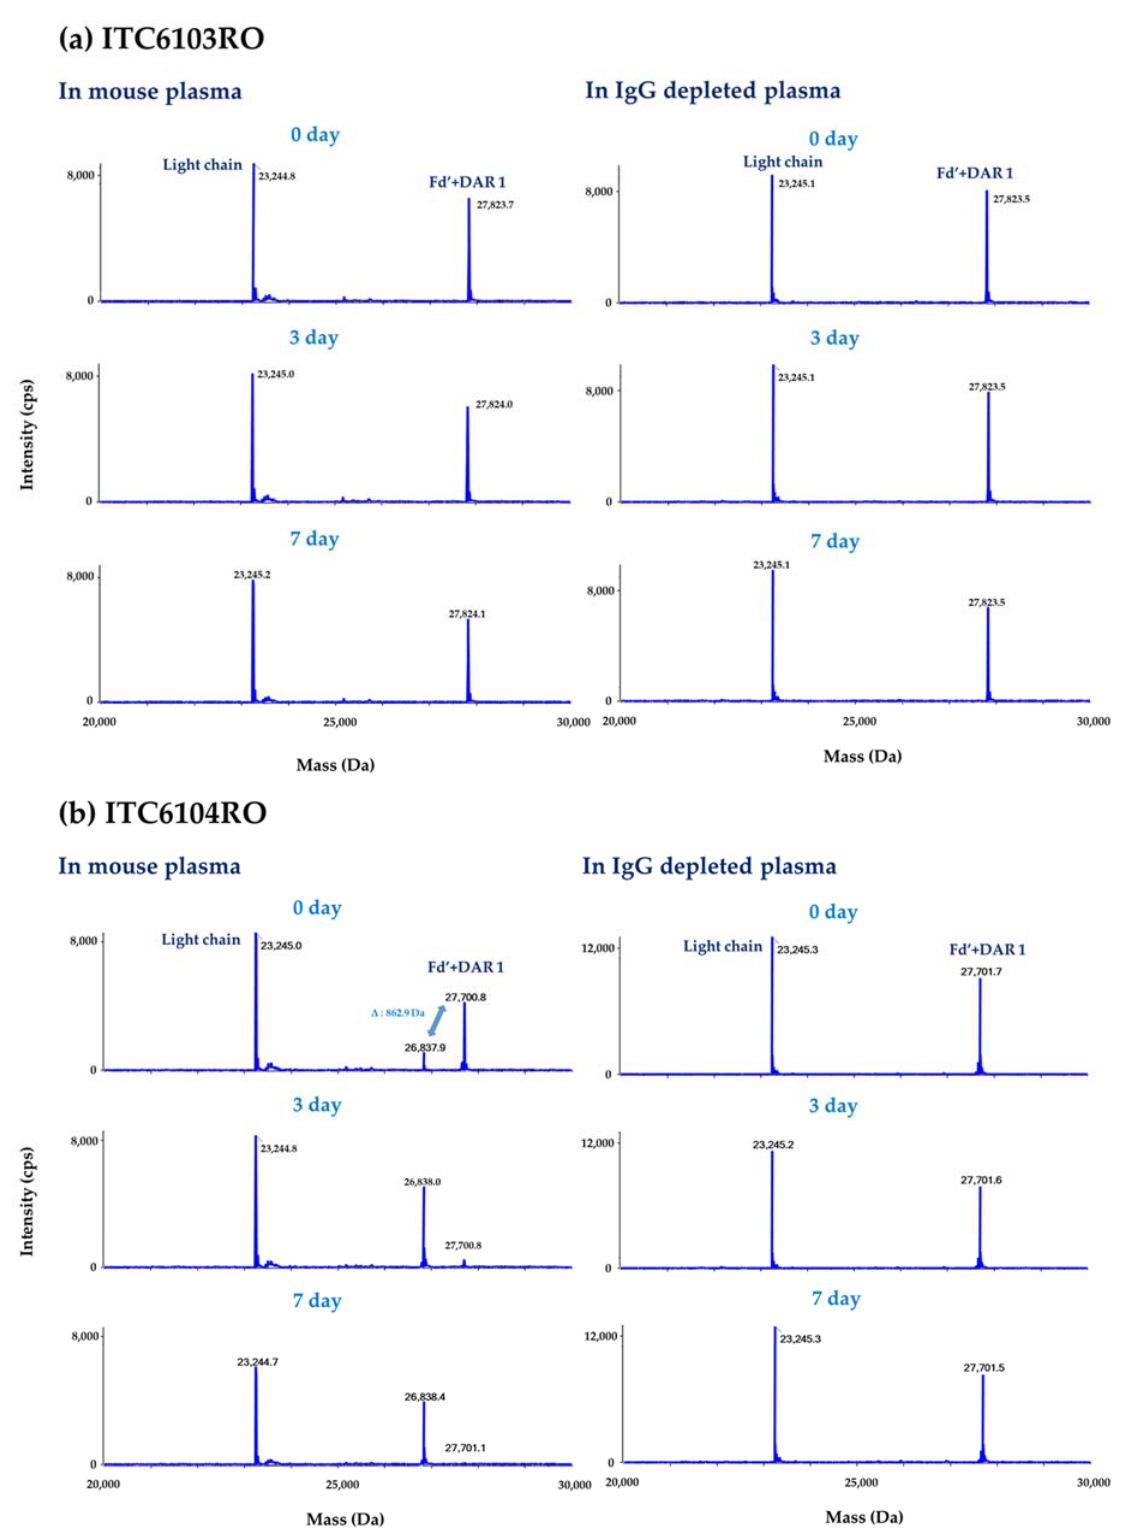
Figure 6. The deconvoluted spectra for ( a ) ITC6103RO and ( b ) ITC6104RO from the in vitro linker stability in mouse plasma and the IgG depleted human plasma samples.